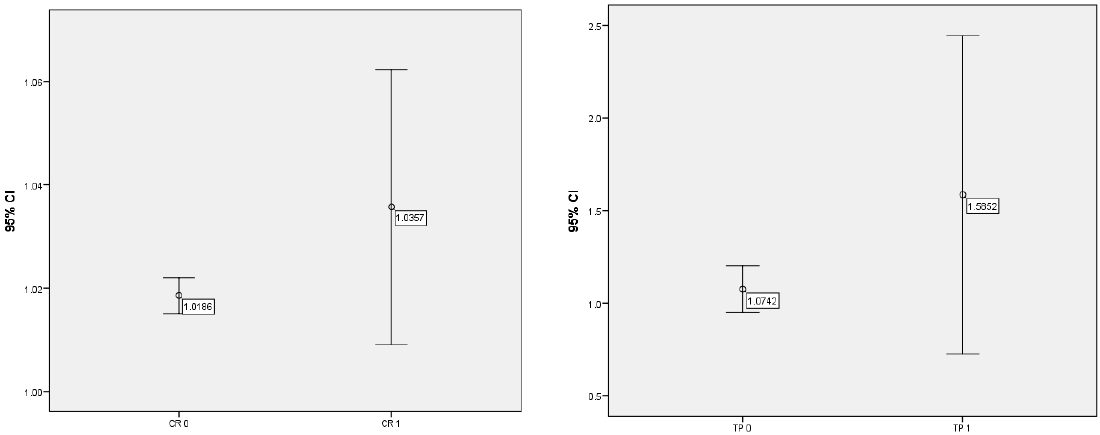
time 1 at a temperature of 1400 °C. Table 5. Paired sample statistics (1400 °C).